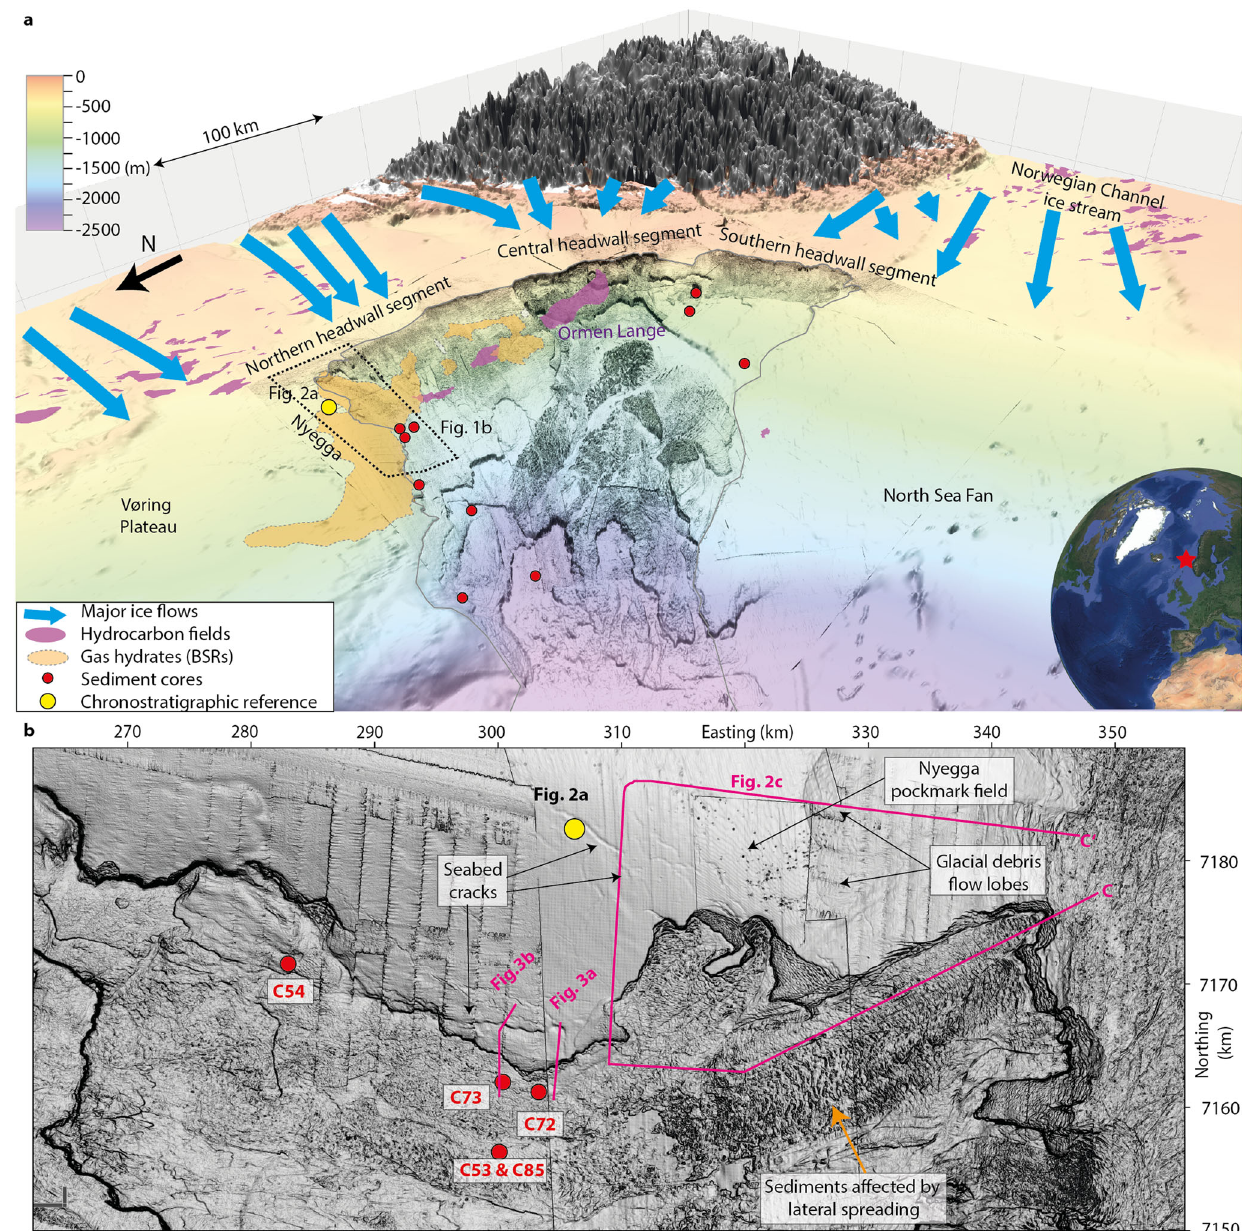
Fig. 1 The Storegga Slide Complex. a Perspective view onto the mid-Norwegian Margin with the Storegga Slide Complex and the neighbouring Vøring Plateau and Norwegian Channel. Red dots show the locations of cores that are inconsistent with the previously established reconstruction model of the Storegga Slide, and dashed black box indicates the area covered by sediment echosounder pro fi les. Globe illustration from Google Earth; Map data: SIO, NOAA, U.S. Navy, NGA, GEBCO, Landsat/Copernicus, IBCAO, U.S. Geological Survey. b Sea fl oor gradient map showing the north-eastern corner of the Storegga Slide Complex with echosounder pro fi les (magenta lines), sediment core locations (red dots) and the location of the reference age-depth model (yellow dot) in Fig. 2a; ref. 14